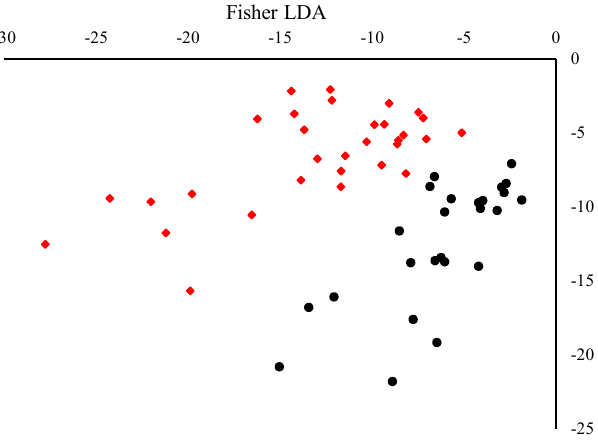
Figure 6. Linear discriminant analysis biplot obtained using non-parametric Fisher type on mode 1 scores of the 12-component DN-PLSR model. (Black circles) EVOOs of Maltese origin and (red diamonds) EVOOs of non-Maltese origin.